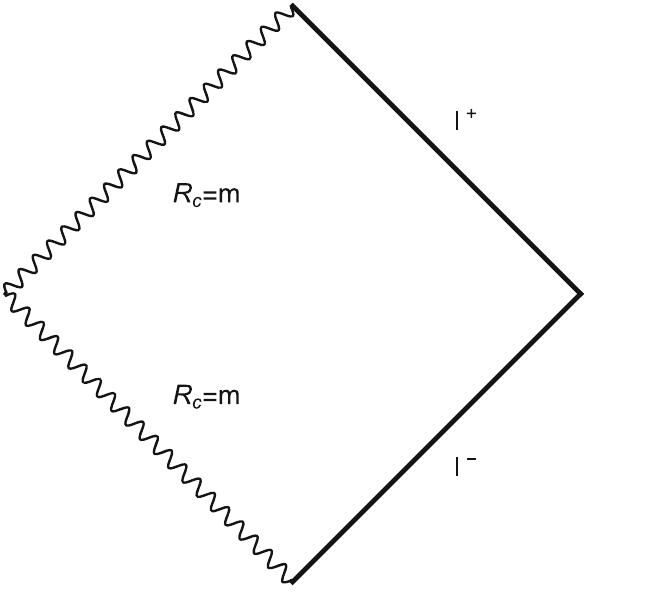
Fig. 6 Conformal diagram of the case m = R c when s = + 1. The center of the object becomes a null hypersurface